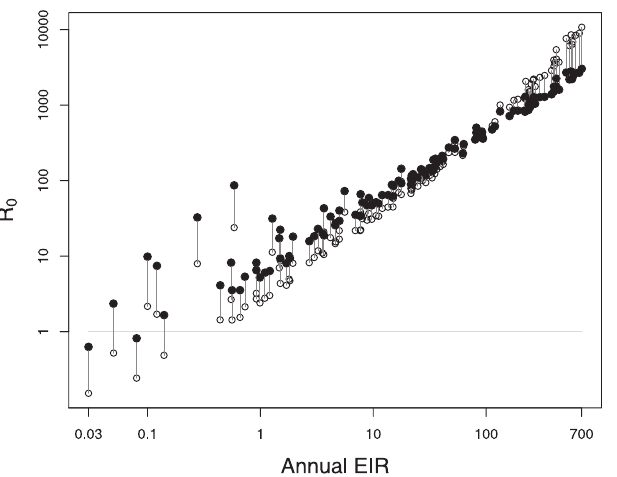
Figure 2. R 0 Estimates for 121 African Populations Here, we show two different sets of estimates, plotted as a function of the estimated EIR. The first set of estimates assumes that none of the parameter estimates are biased by immunity or heterogeneous biting at the equilibrium (solid circles). The second set of estimates assumes that heterogeneous biting and transmission-blocking immunity bias param- eters (open circles); r is as illustrated by Figure 3. Corrections for this potential bias substantially increase the range of R 0 estimates.